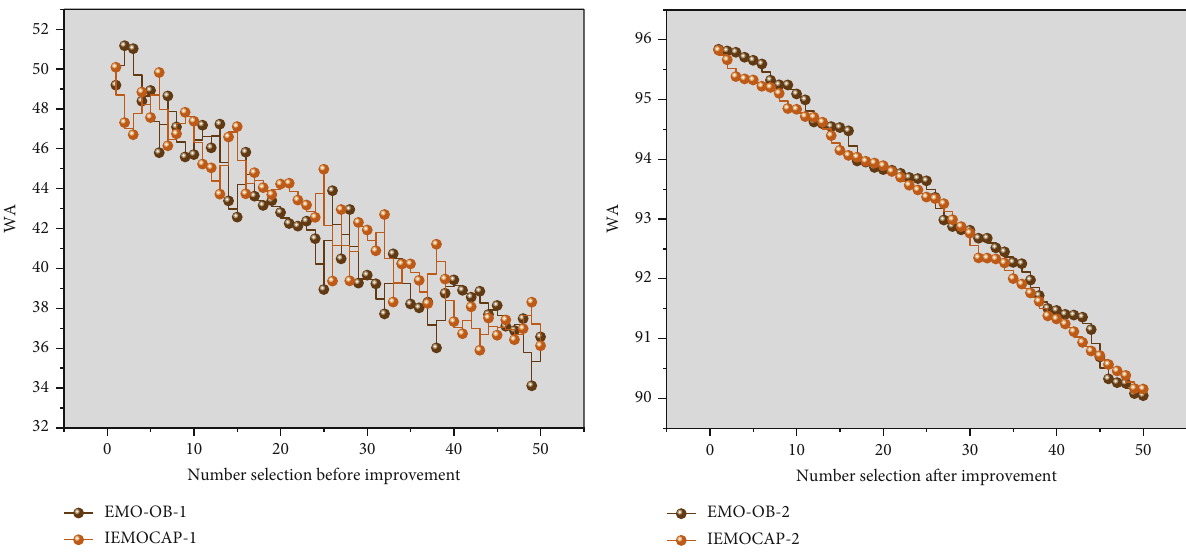
Figure 8: Comparison of experimental results of classroom emotion